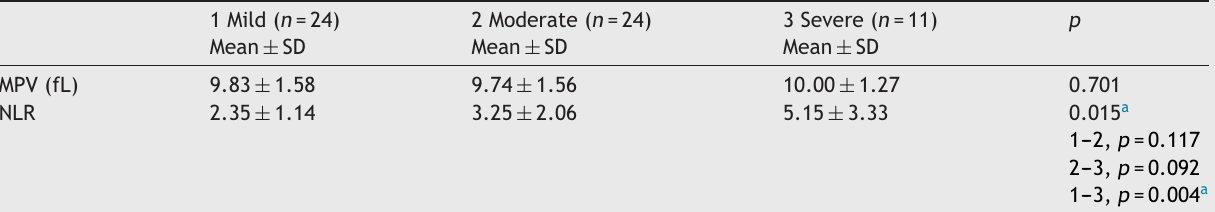
Mean analysis for NLR and MPV according to severity of hearing loss as mild (<40 dB), moderate (up to 80 dB), and severe (profound, >80